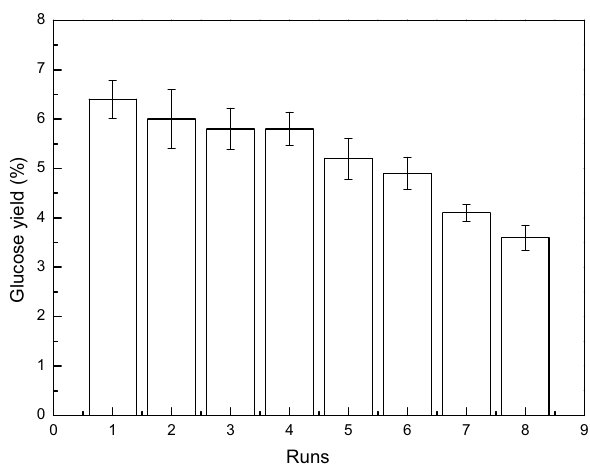
Fig. 14 Reusability of solid catalysts in one-pot reaction. Reaction conditions: 0.1 g MCC, 0.1 g solid acid catalyst and 4 mL solvent, 373 K, 3 h